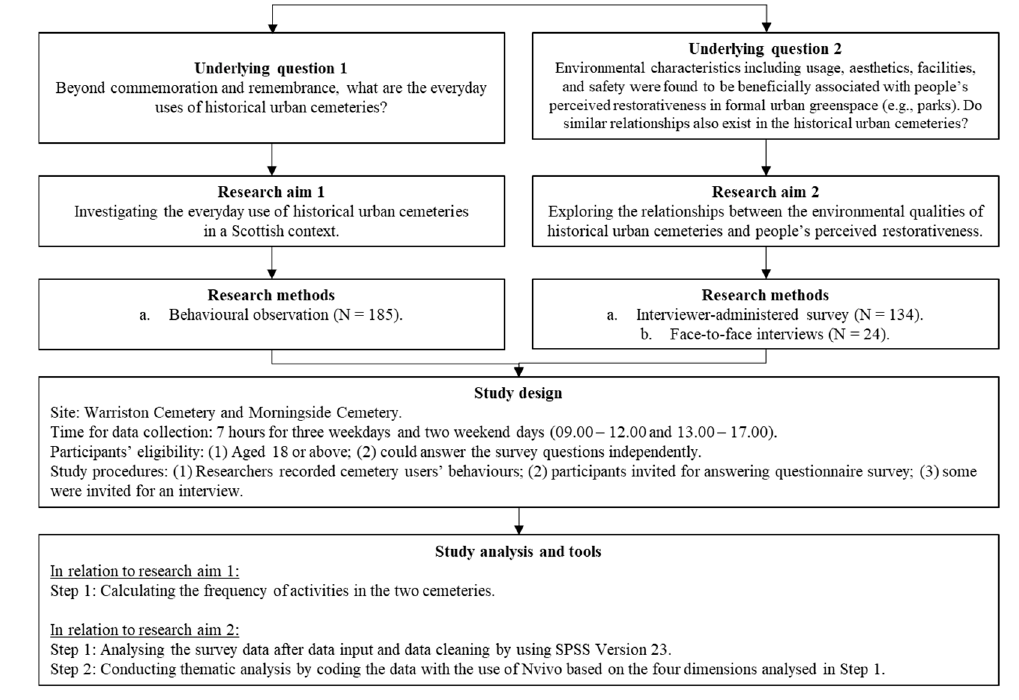
Figure 1. Research procedures in relation to the research questions.